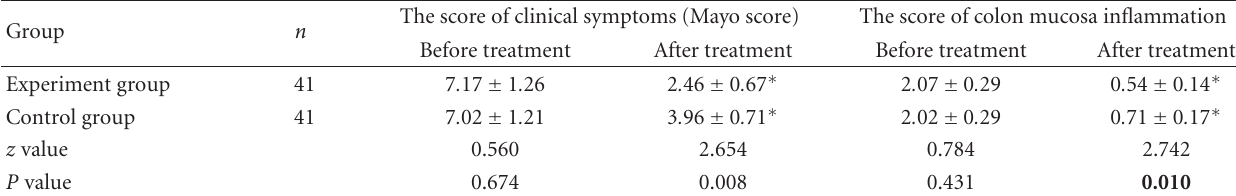
Table 2: Clinical symptom score and colon mucosa inflammation score ( x ± s ).